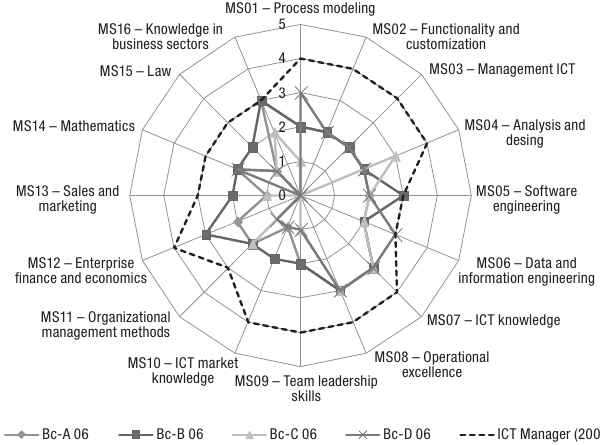
Fig. 2. Knowledge provided by bachelor’s fields of study vs demand for knowledge by companies for the role of ICT manager in 2006 Source: